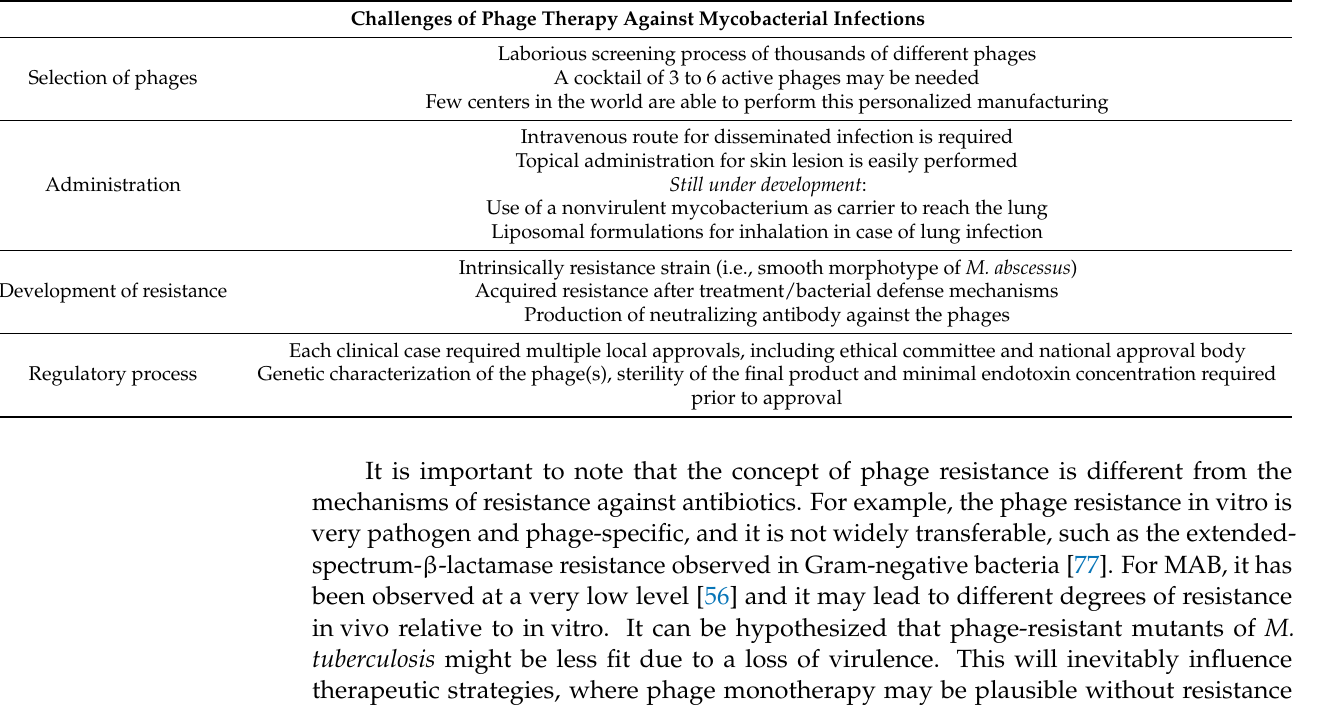
Table 2. Challenges of phage therapy against mycobacterial infections, from the selection of phages, the necessary regulatory approvals and treatment